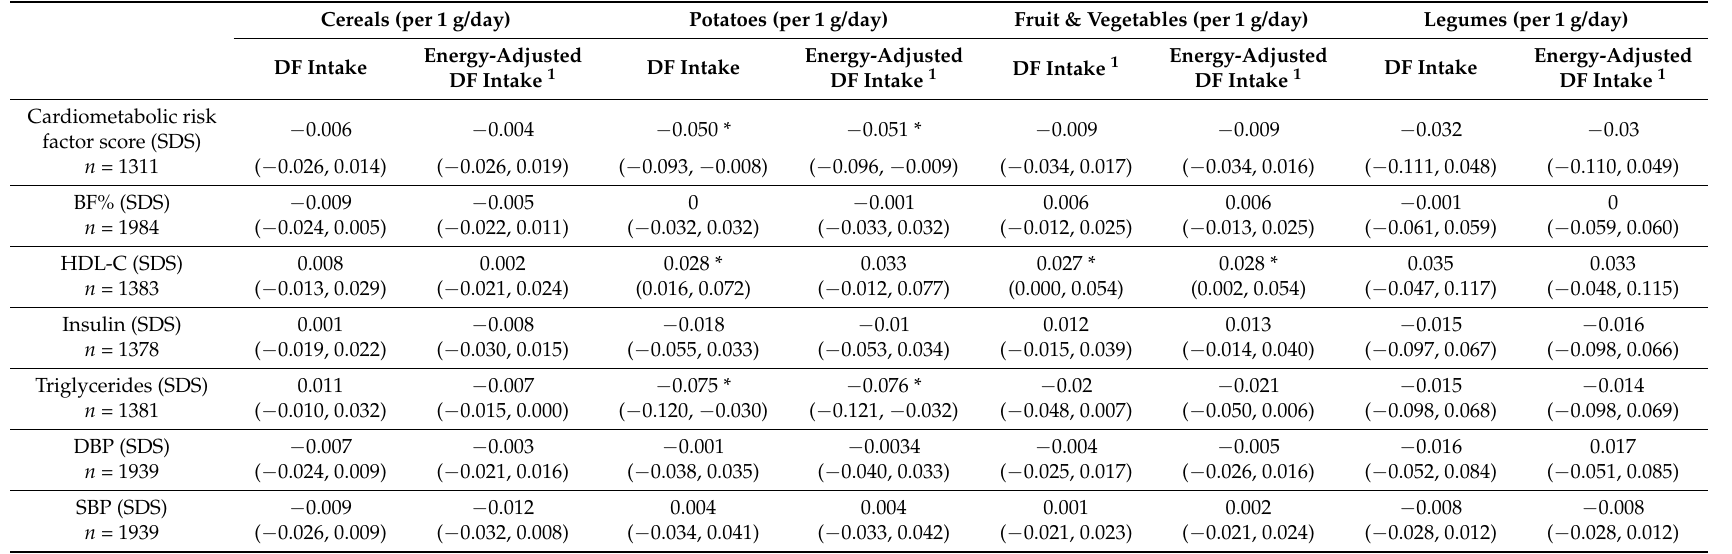
Table 3. Covariate-adjusted associations between DF intake and energy-adjusted DF intake from cereals, from potatoes, from fruits and vegetables, and from legumes (per 1 g/day) and cardiometabolic